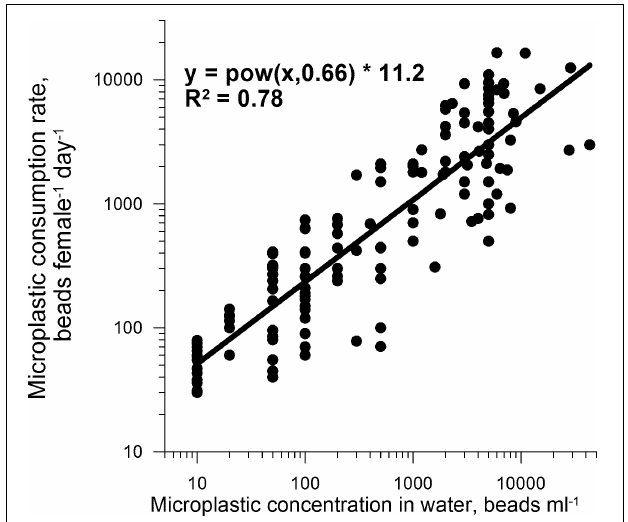
FIGURE 6 | Weight-specific respiration rates of active (black bars) and anesthetized (gray bars) (for total and basal metabolism, respectively) Calanus helgolandicus females on the 3rd day of the experiment (see Figure 2 ). Specimens were fed algae Rhodomonas salina (Treatment RESP1), a mixture of algae R. salina and microplastics of 6 and 12 µ m diameter (5,000 cells/beads per ml, Treatment RESP2), microplastic beads of 6, 12, and 26 µ m diameter at concentrations of 5,000 beads/ml each (Treatments RESP3, RESP5, and RESP6, respectively) and starvation (Treatment RESP4). (Low-case letters (a, b, bc, c, cd, d) denote significant variable differences among means of different treatments from Duncan’s Multiple Range test, P <